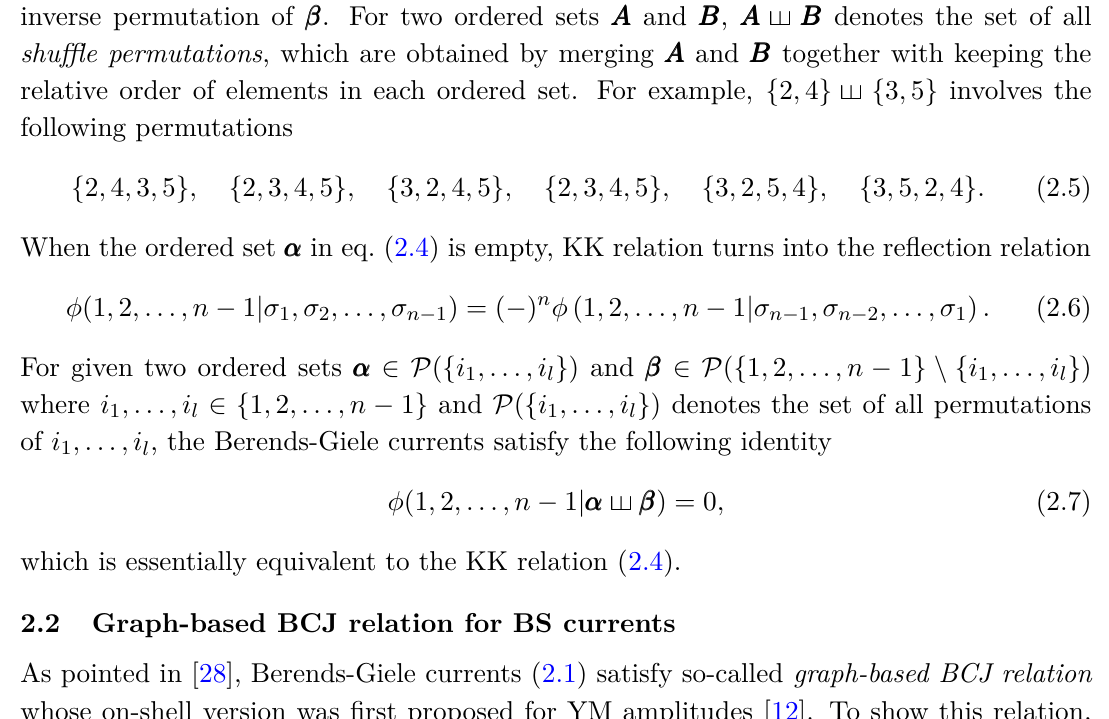
Figure 1 . A connected tree graph T with eight nodes. When the nodes 1 and 2 are chosen as the leftmost elements respectively, the corresponding permutations are T (cid:12) (cid:12) 7 } (cid:1) 8 (cid:9)(cid:9) and T (cid:12) (cid:12) = (cid:8) 2 , 5 , 1 , 6 , 8 (cid:1) { 4 , 3 (cid:1) 7 } (cid:9) 2